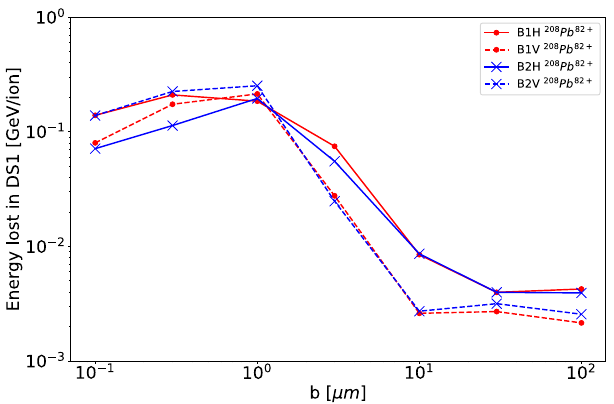
FIG. 5. Energy lost in the DS1 cluster as a function of b for 6.37 Z TeV horizontal and vertical 208 Pb 82 þ ion beams using the 2018 colliding